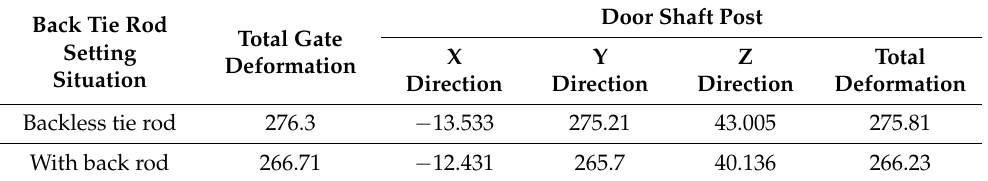
Table 4. The maximum deformation of the gate with or without the back rod in the static state mm. Back Tie